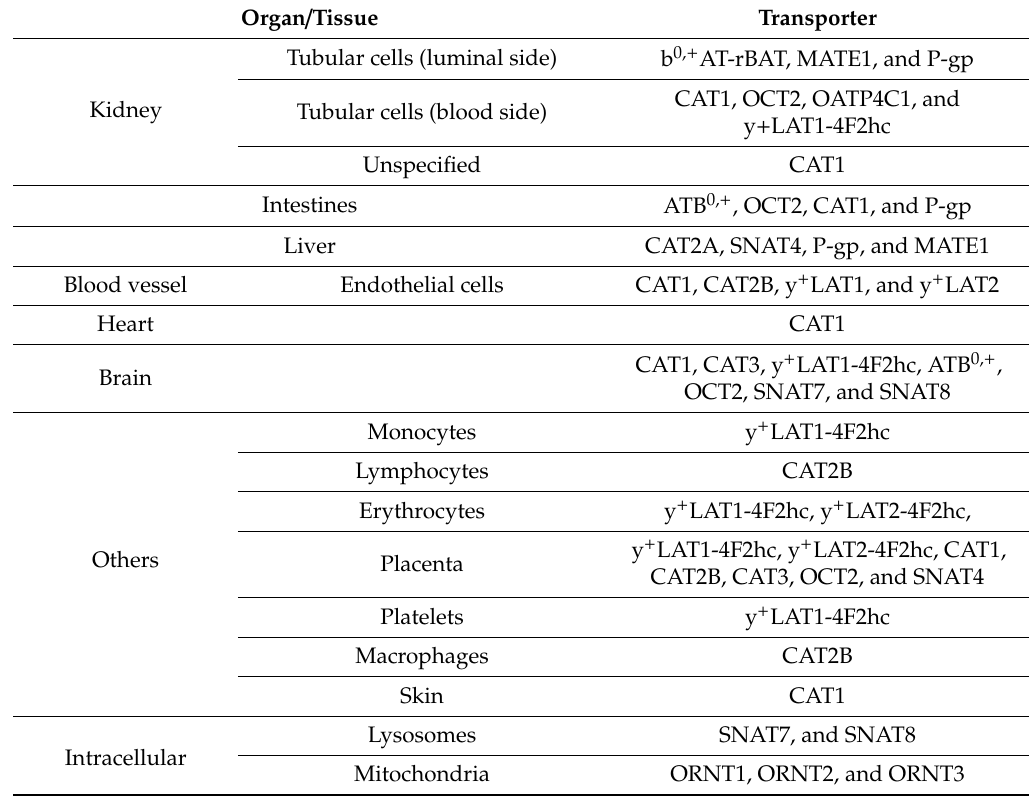
Table 3. An overview of tissue distribution of L-arginine and its derivatives transporters on selected organs and tissues (based on mRNA and protein